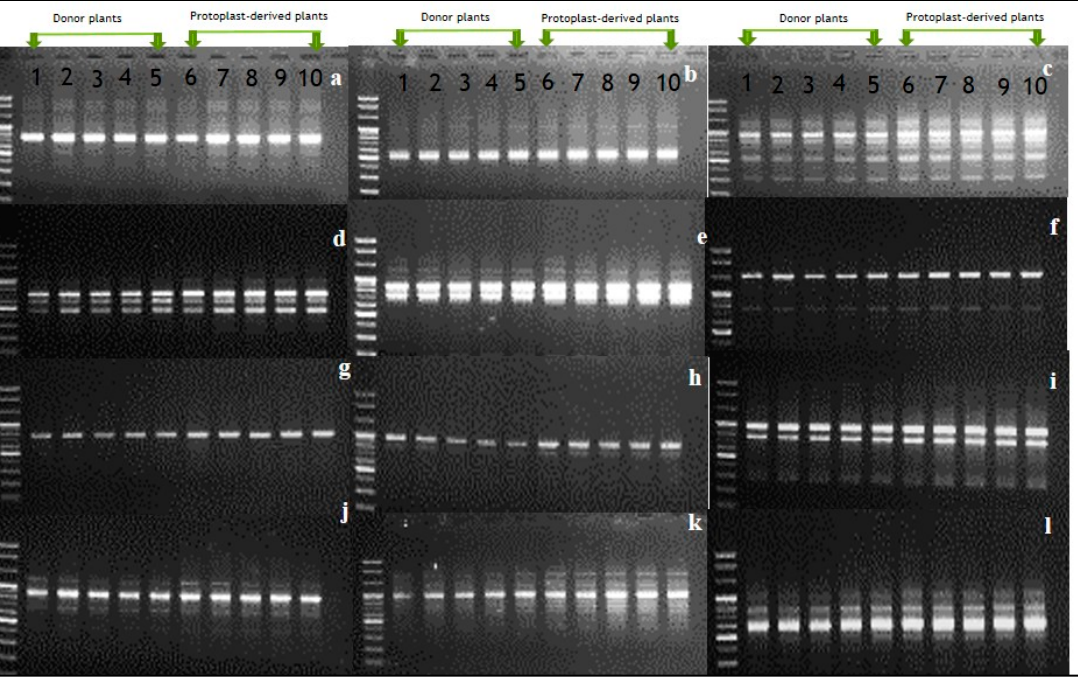
Figure 7. Detection of somaclonal variation between protoplast-derived plants and donor plants using random amplification of polymorphic DNA markers. ( a ) OPA-01, ( b ) OPA-02, ( c ) OPA-04, ( d ) OPA-09, ( e ) OPA-10, ( f ) OPA-12, ( g ) OPA-15, ( h ) OPB-2, ( i ) OPB-10, ( j ) OPB-11, ( k ) OPB-12, and ( l ) OPB- 17.